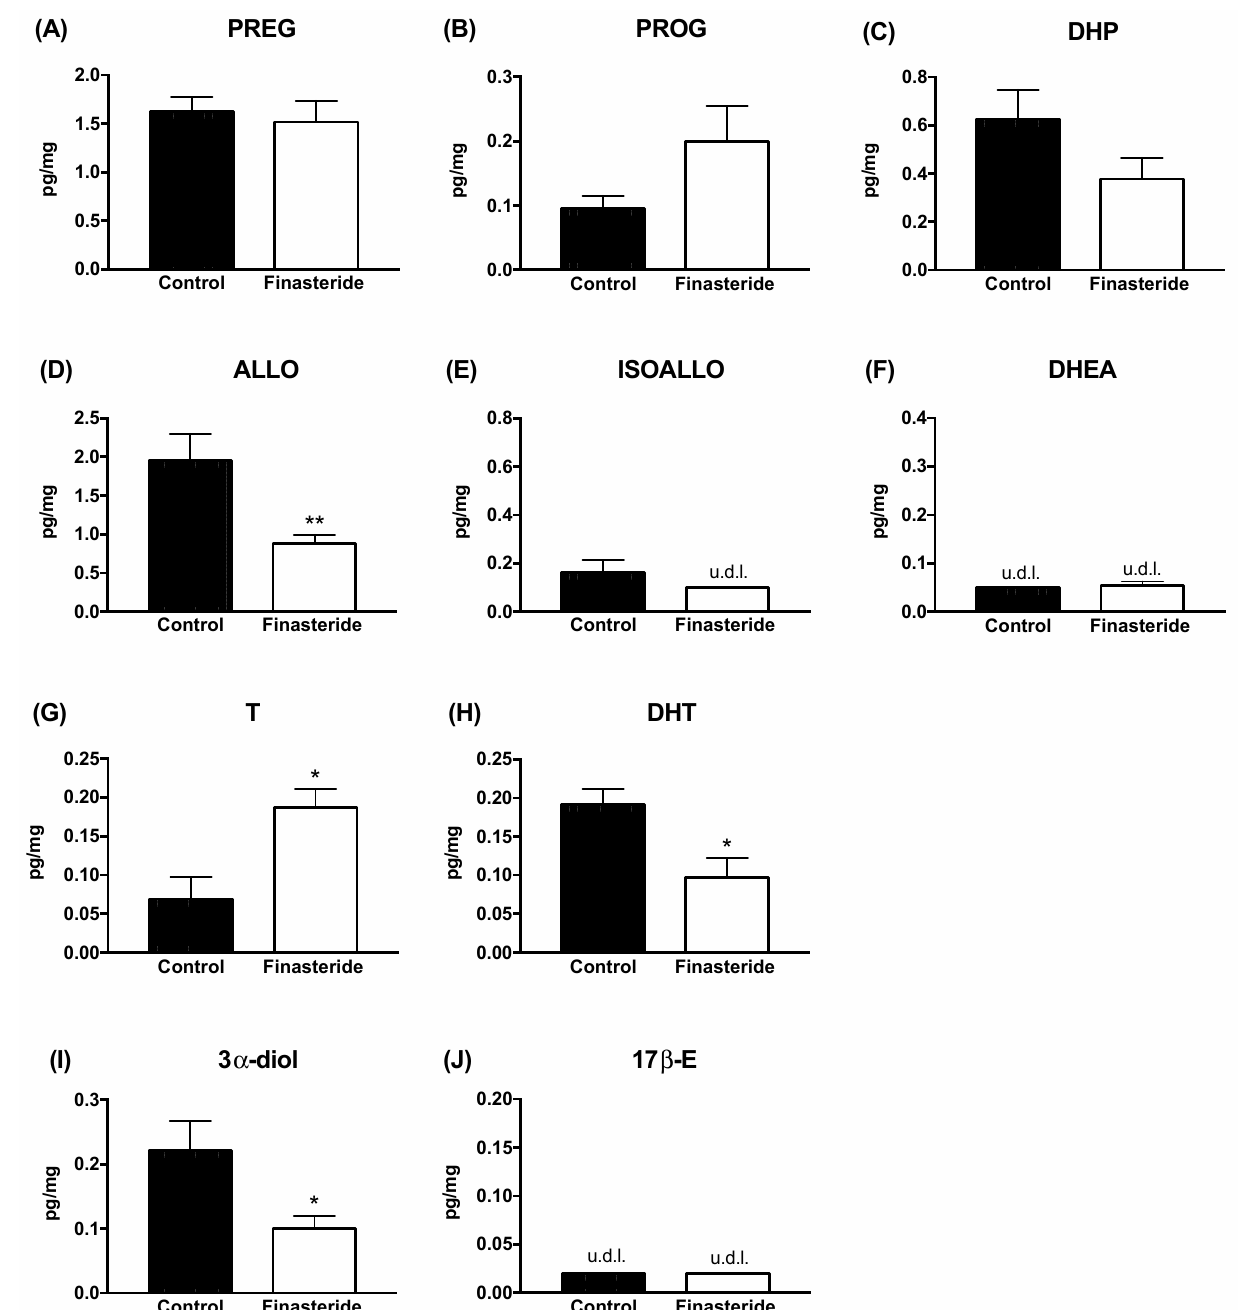
Figure 1. Levels of gut steroids in the colon of the control (black bar) and finasteride-treated (white bar) rats: effect after treatment. Pregnenolone (PREG, ( A )), progesterone (PROG, ( B )), dihydroprogesterone (DHP, ( C )), allopregnanolone (ALLO, ( D )), isoallopregnanolone (ISOALLO, ( E )), dehydroepiandrosterone (DHEA, ( F )), testosterone (T, ( G )), dihydrotestosterone (DHT, ( H )), 5 α -androstane-3 α , 17 β -diol (3 α -diol, ( I )) and 17beta-estradiol (17 β -E, J ). Data are expressed as pg/mg ± SEM, n = 6 for each group. Unpaired Student’s t-test analysis: * p < 0.05, ** p < 0.01 vs. control rat colon. U.d.l. = under the detection limit. Detection limits were 0.05 pg/mg for dehydroepiandrosterone, 0.1 pg/mg for isoallopregnanolone and 0.02 pg/mg for 17 β -Estradiol.